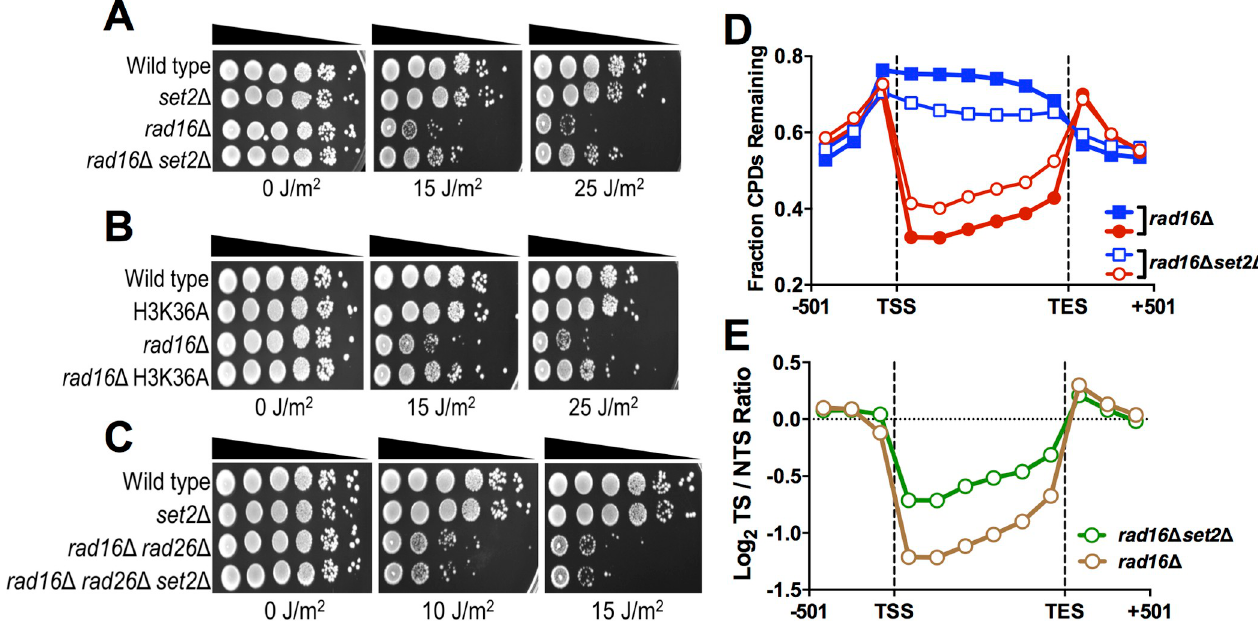
Fig 4. Deletion of SET2 restores UV resistance in a GG-NER deficient strain by promoting repair of the NTS. (A-C) Indicated mutant yeast strains were serially 10-fold diluted, spotted, and exposed to the specified UVC doses. (D) The average fraction of CPDs remaining after 2-hour repair (relative to 0hr control) was plotted from CPD-seq data for both the transcribed strand (TS) and nontranscribed strand (NTS) for approximately 5000 yeast genes in rad16 Δ and rad16 Δ set2 Δ cells. CPD-seq data for each gene was divided into 6 equally sized bins and fraction of CPDs remaining was analyzed in each bin. The fraction of CPDs remaining in 3 bins consisting of consecutive 167 bp regions of flanking DNA upstream of transcription start site (TSS) or downstream of transcription end site (TES) is also depicted. Red symbols/line indicates the transcribed strand (TS); blue symbols/line indicates the non-transcribed strand (NTS). (E) The log ratio of unrepaired CPDs on the TS relative to the NTS in the rad16 Δ and rad16 Δ set2 Δ cells is depicted.